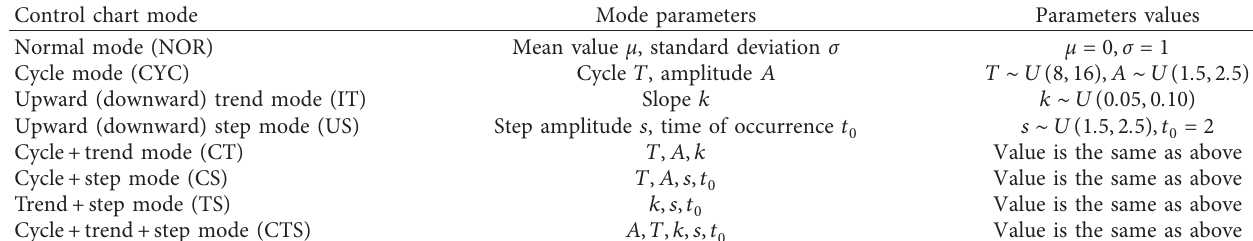
Table 1: Parameter settings for various abnormal conditions.